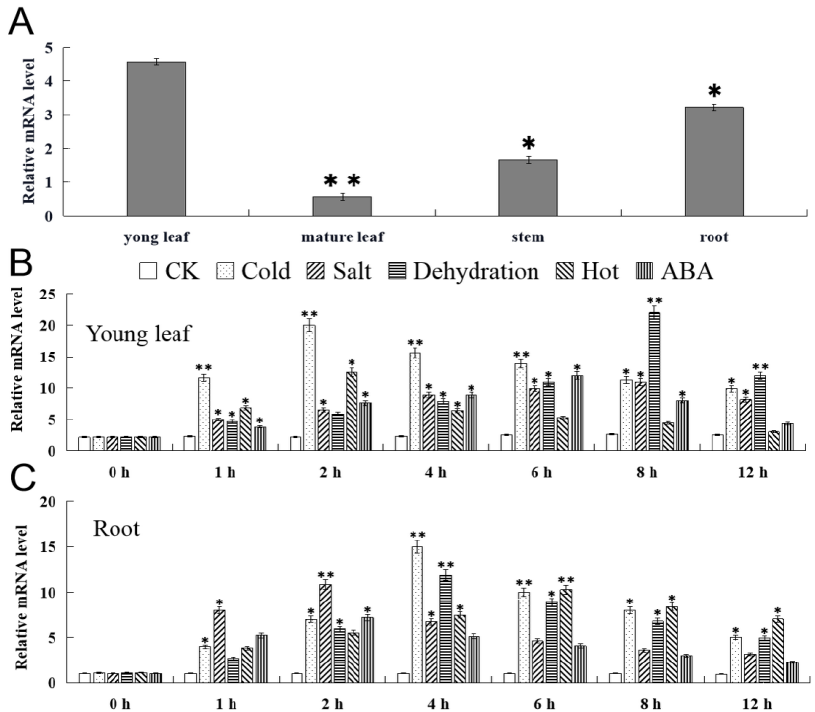
Figure 4. Expression pattern analysis of FvMYB82 in F . vesca by quantitative RT-PCR. ( A ) Expression of FvMYB82 in different tissues in the non-stress environment. ( B , C ) Time course of FvMYB82 expression in young and root in the control and under treatment with salt (200 mM NaCl), heat (30 ◦ C), cold (4 ◦ C), dehydration (15% PEG6000), and abscisic acid (50 µ M ABA). Error bars indicate the standard deviation. Asterisks above the error bars indicate a significant difference between the treatment and control (Student’s t -test; * p ≤ 0.05, ** p ≤ 0.01). 2.4. Overexpression of FvMYB82 in A. thaliana Enhanced Salt Tolerance Among 12 the transgenic A. thaliana plants, only five lines (L1, L2, L3, L4, and L5) were identified as transgenic plants by using the real-time fluorescent quantitative PCR (qPCR), with the wild-type (WT) and unloaded line (UL) lines as controls (Figure 5A). Therefore, T 3 transgenic A. thaliana lines were used as test materials for further analysis. According to the statistics of the germination rates of WT, UL, and transgenic lines, it was found that the germination rates of the five groups of A. thaliana plants were not different under normal growth conditions. Under salt stress, the germination rates of WT and UL were 25% and 28%, respectively. The germination rates of L1, L3 and L5 lines were 70%, 68%, and 69%, respectively (Figure